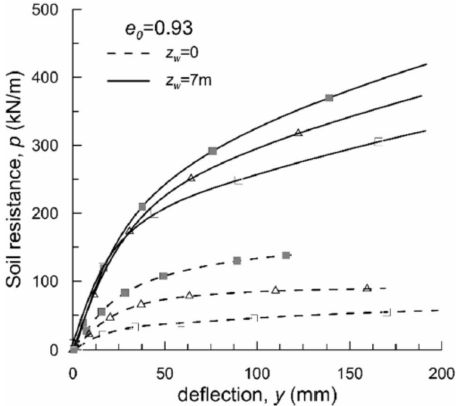
Figure 12. Curves p-y at different depths and water table positions for the loose model.